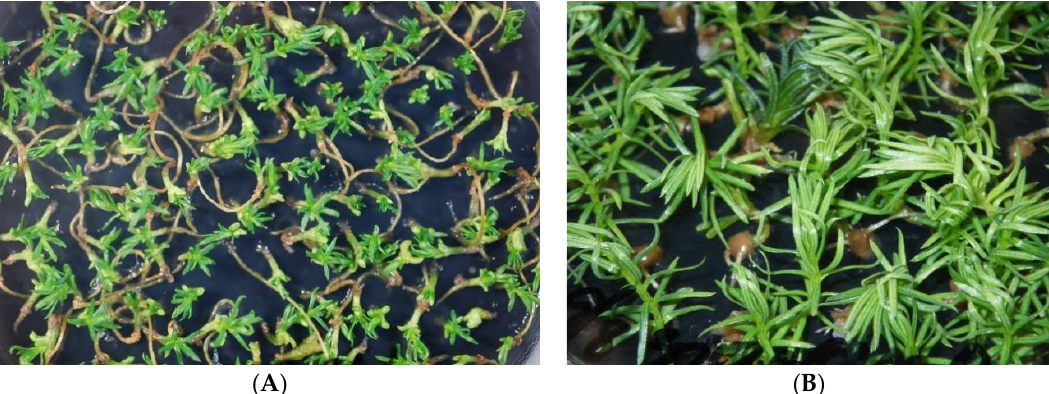
Figure 4. Somatic embryo germination and plantlet conversion in sugi (Japanese cedar, C. japonica ). ( A ) Germination of somatic embryos about 2 weeks after the transfer to germination medium; ( B ) plantlet conversion about 6 weeks after somatic embryo germination. Bars : 1 cm.